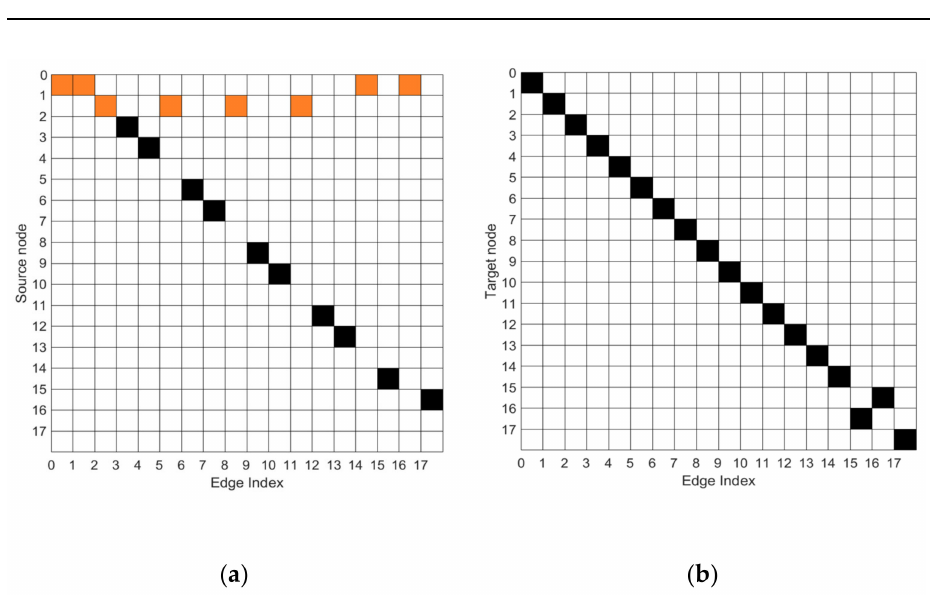
Figure 2. ( a ) Source matrix, ( b ) Target matrix. Color-none is 0, color-black is 1, and color-orange is